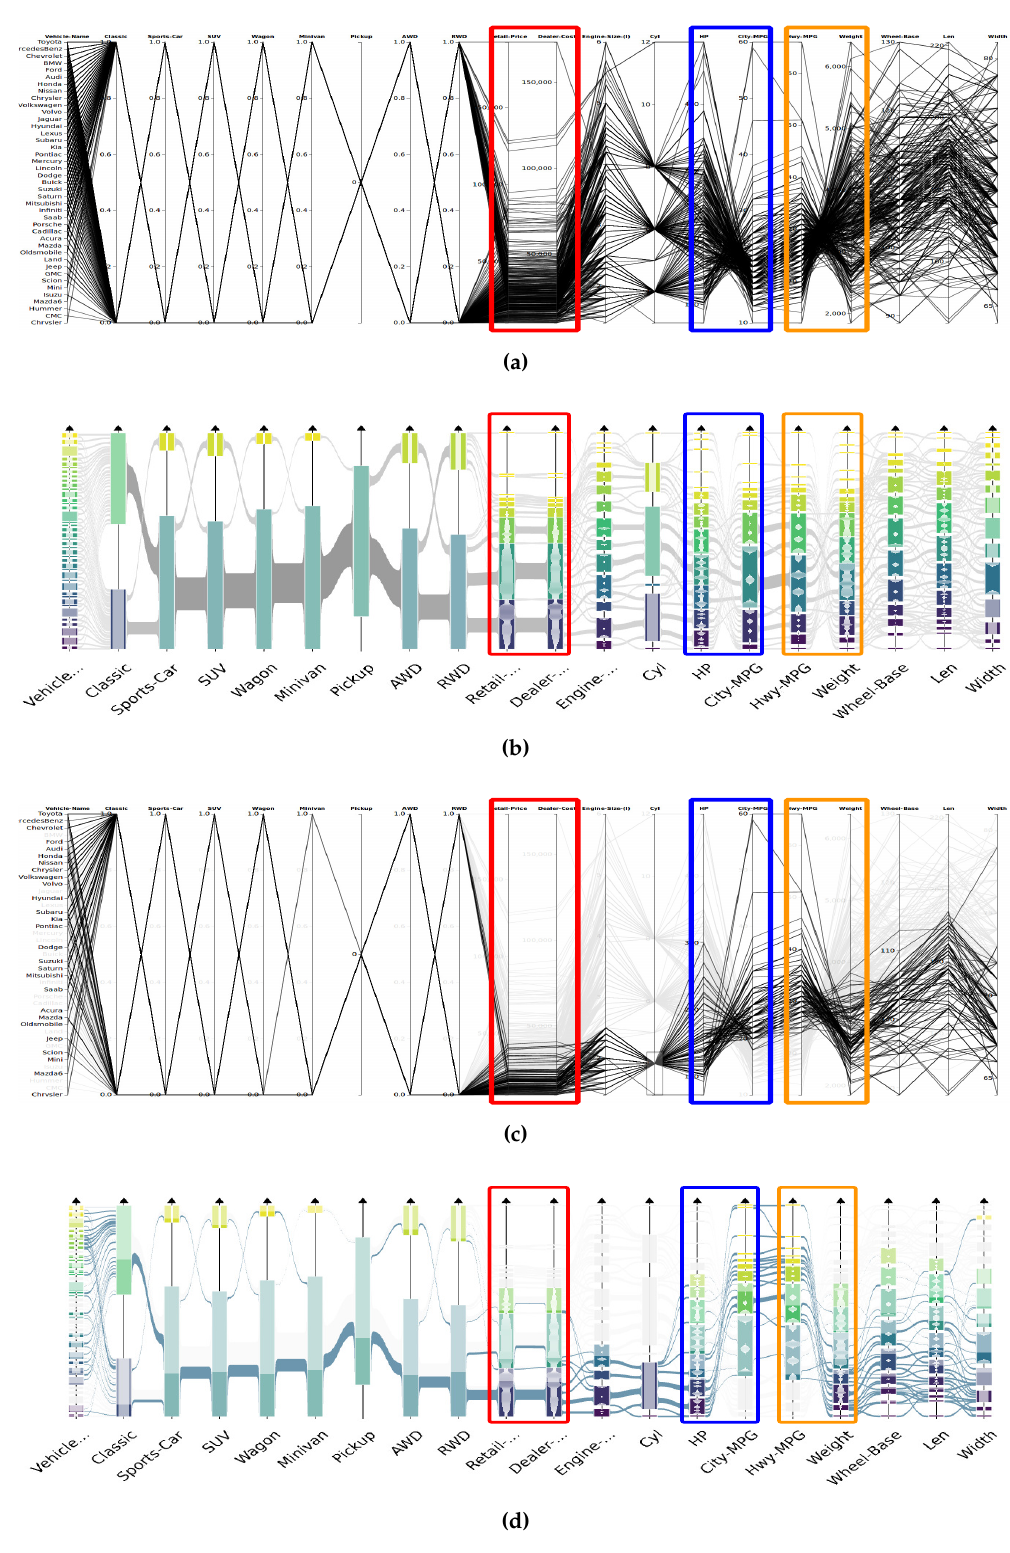
Figure 7. Cars dataset: ( a , b ) show an overview of the dataset; ( c , d ) are selections of the cars with less than 4 cylinders; ( a – c ) use the traditional parallel coordinates implementation of the Tulip software [45] and ( b – d ) use our